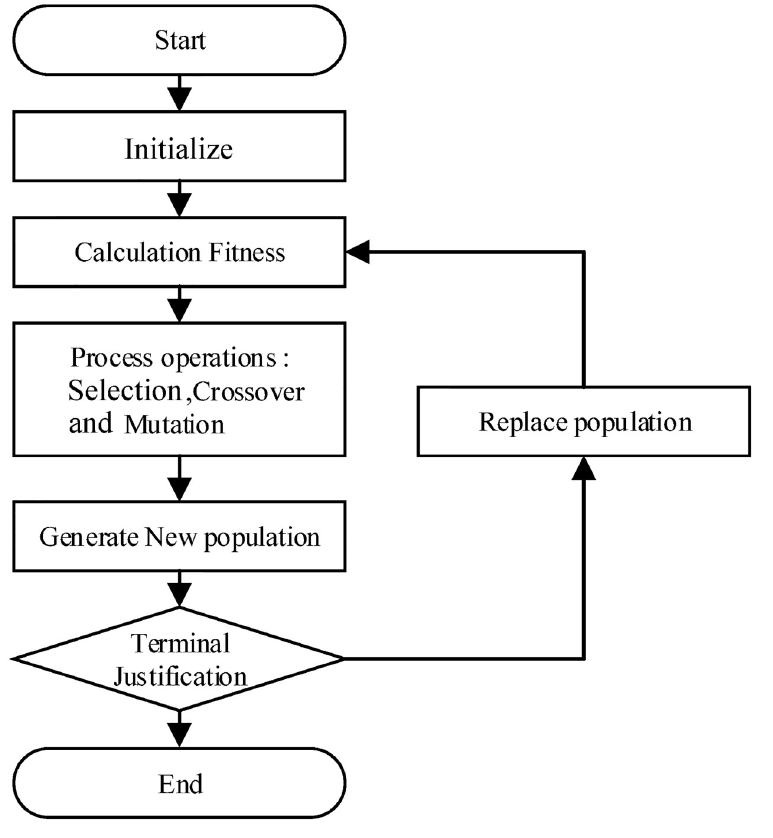
Fig 10. A flowchart of genetic algorithm.